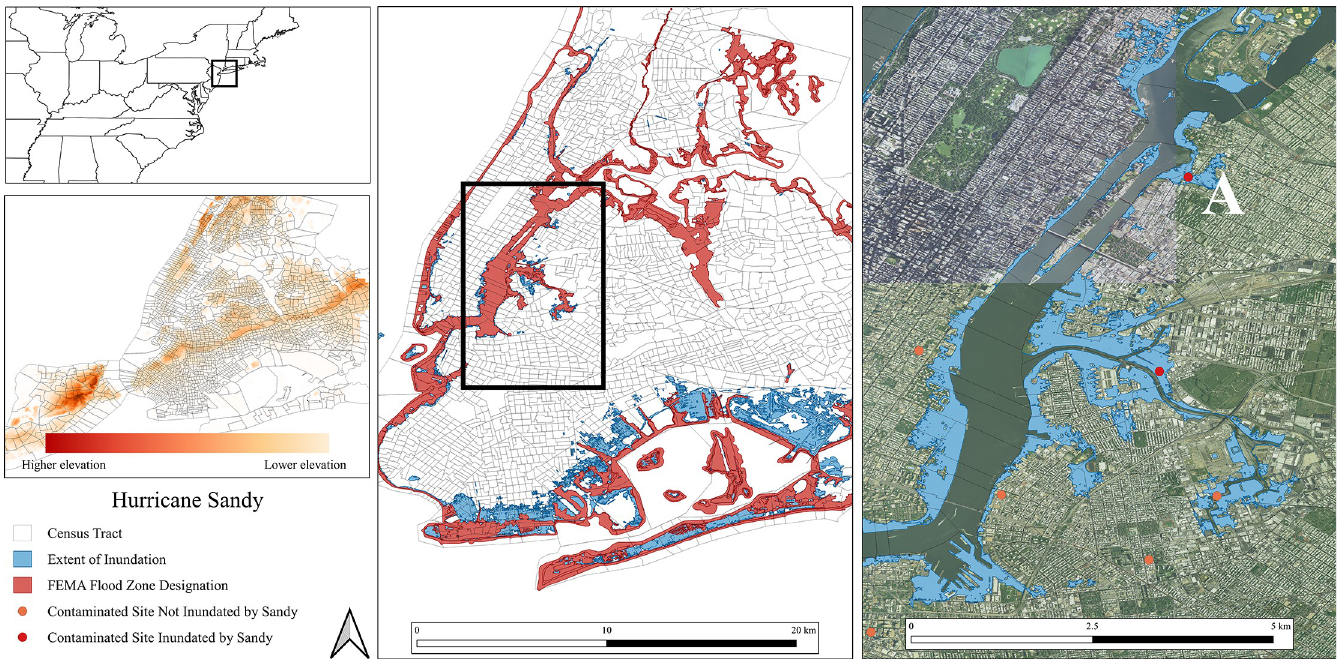
Fig 3. Flooding and inundated contaminated sites that occurred during and post-Hurricane Sandy in New York City, New York.